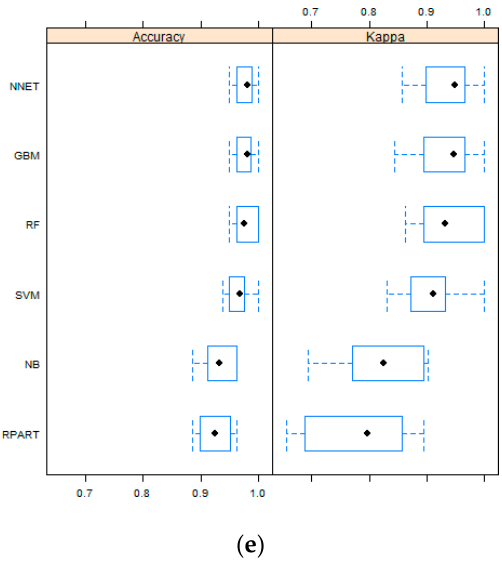
Figure 3. The boxplot of overall accuracy (OA) and the Kappa coefficient (Kappa) using different machine learning algorithms for provided multiband data: ( a ) LS8; ( b ) LS8 + Slope; ( c ) LS8 + NDVI; ( d ) LS8 + NDWI; and ( e ) LS8 + Slope + NDVI + NDWI.